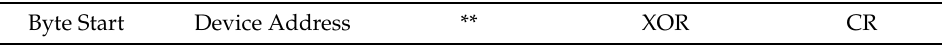
Table 6. MCU verification error response command.